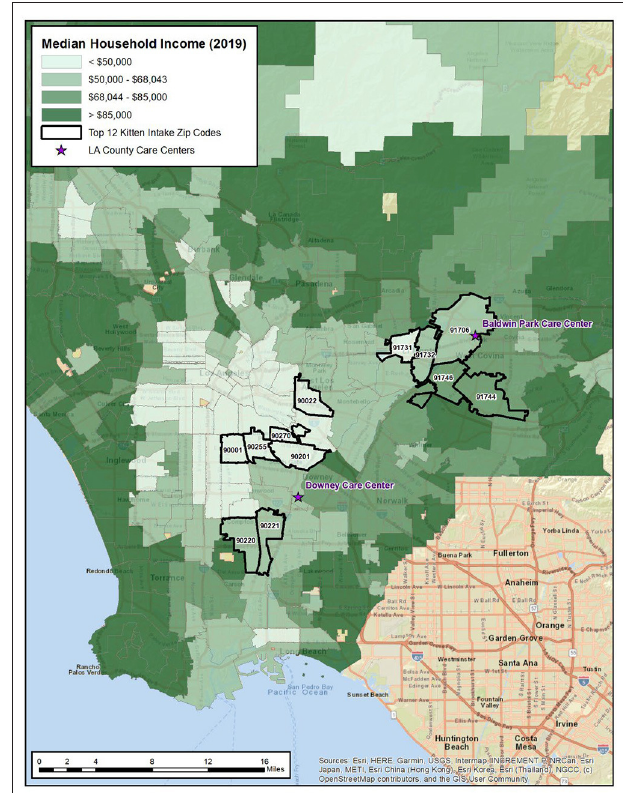
FIGURE 1 | Median household